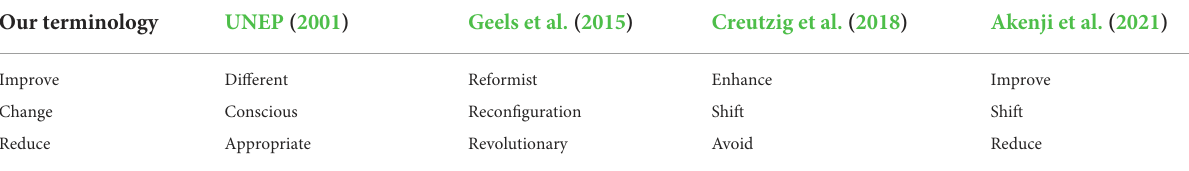
TABLE 1 Different ways to categorize steps in the transition to sustainable consumption. Our